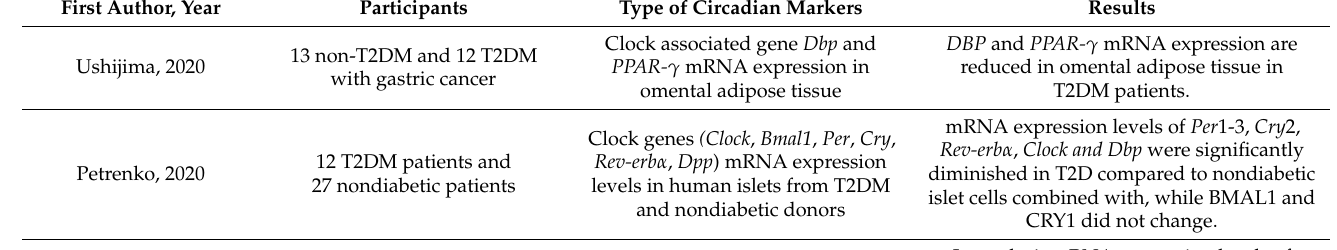
Table 2. Circadian rhythm disruptions among T2DM